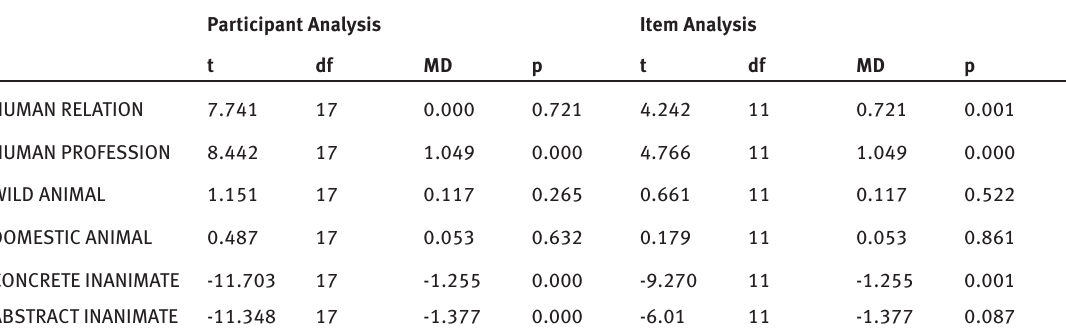
Table 4. Pairwise comparisons of overt and zero marking of DOM for each sub-animacy